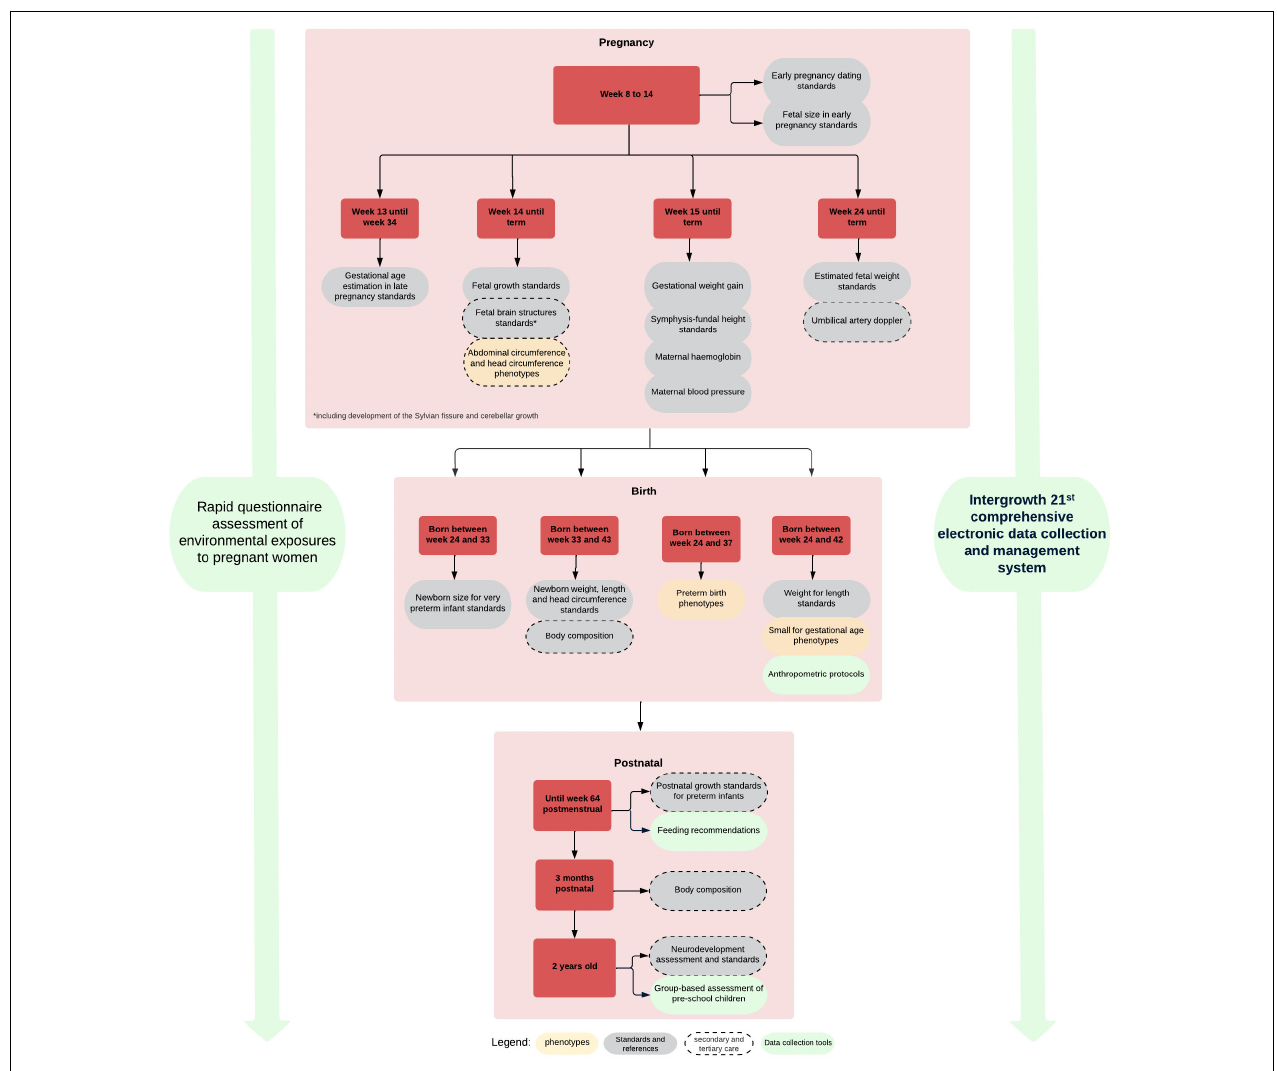
FIGURE 7 | INTERGROWTH-21st growth, developmental standards, clinical and data collection